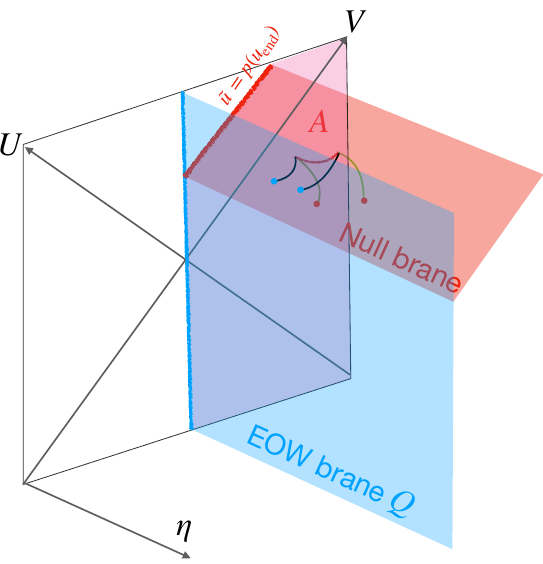
Figure 21 . An extra null brane (red shaded surface) is inserted in the bulk spacetime. Different from the standard AdS/BCFT setup with one timelike EOW brane (blue surface), the appearance of a null brane at U = p ( u ) would result in a different state. In this case, the disconnected extremal end surface for subsystem A may end on the null surface (denoted by the green curves) instead of ending on the timelike EOW brane. In this paper, we only explore the latter case with one EOW brane, where the corresponding extremal surface (black curves) anchors to the EOW